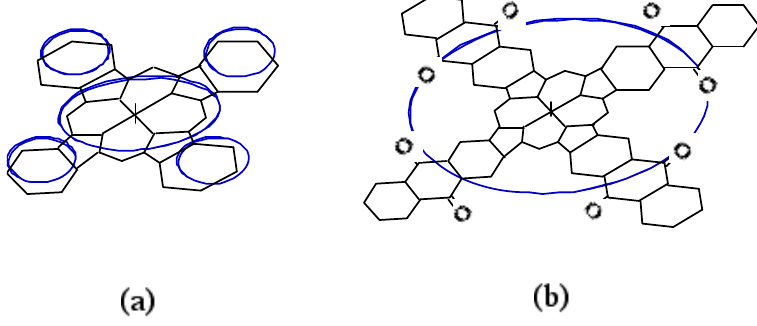
Figure 12. Ring current model of phthalocyanine ring and anthraquinocyanone ring. (a) Five-loop model. (b) Single-loop model.